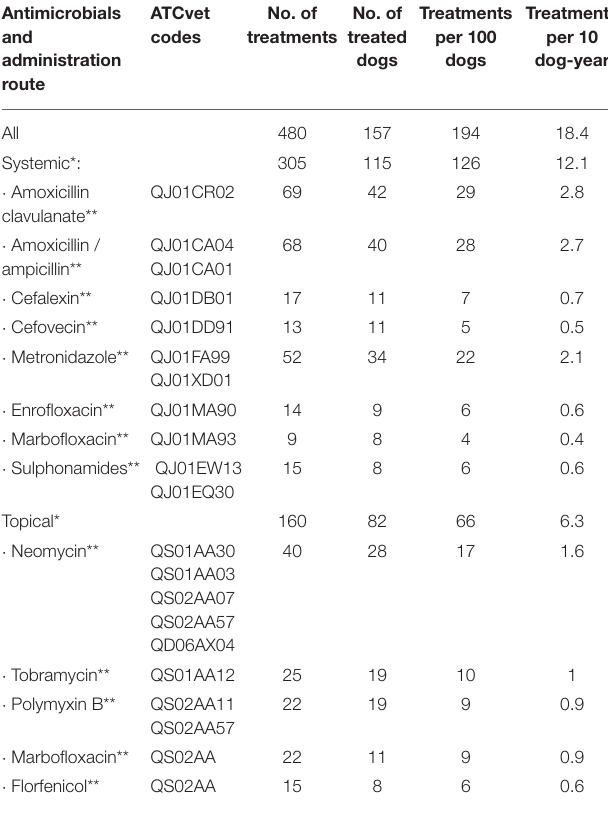
TABLE 2 | Antimicrobial exposure from a 1-year follow-up study of 248 dogs (95,171 dog-day) in Madrid, Spain. Antimicrobials